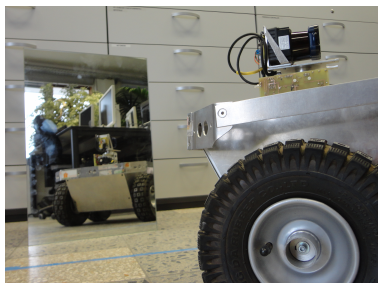
Figure 1: Robot equipped with the 3D-Hokuyo multi-echo laser scanner facing an unframed